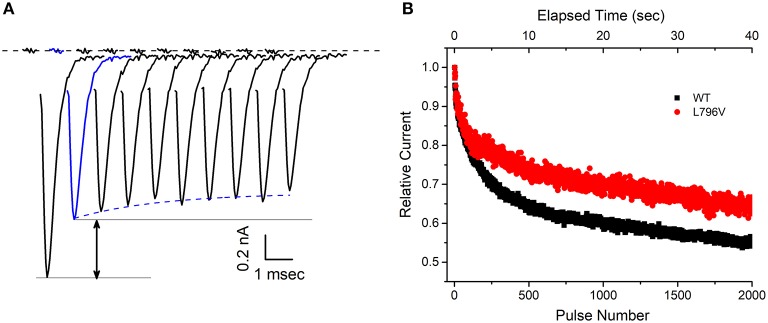
The decline of sodium current peak amplitudes during a 50 Hz train of pulses is less pronounced for L796V channels, thereby showing a gain-of-function change caused by altered slow inactivation. (A) Exemplary WT sodium currents elicited by the first 10 pulses in a 50 Hz train of 3 ms depolarizations to −10 mV are shifted in time and superimposed to illustrate the decline in peak amplitude. The holding potential between pulses was −80 mV. The large decline between the first and second pulse (black arrow) reflects trapping of channels in the fast-inactivated state. The subsequent decline starting from the second pulse (blue) is caused by loss of channels successively trapped in the slow-inactivated state. (B) The decline in peak sodium current during a prolonged 50 Hz train of 3 ms pulses is attenuated for L796V channels. Points show mean relative current for WT (n = 7) and L796V (n = 3) channels, as defined by normalization to the peak amplitude of the sodium current elicited by the second pulse (blue).